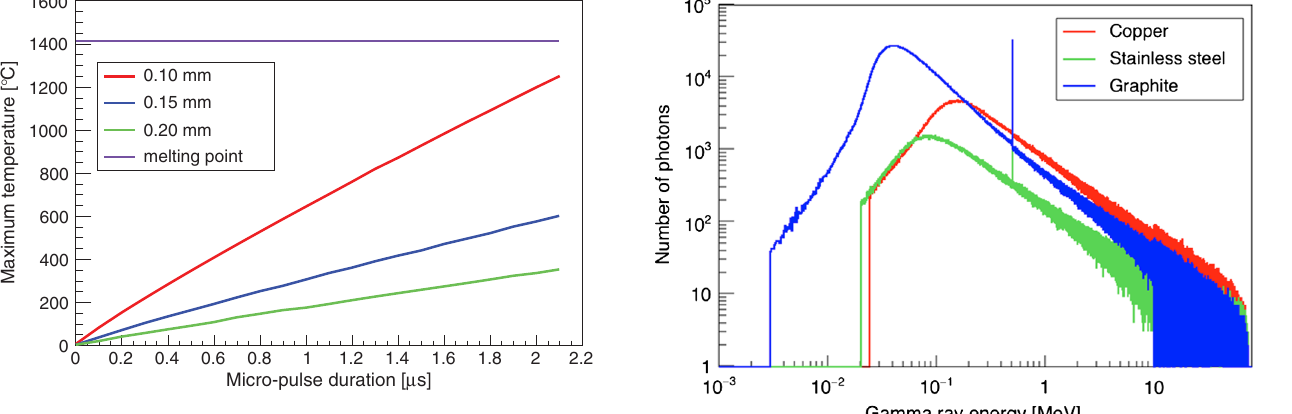
FIG. 12. Gamma rays generated when a beam with 10 7 electrons at 75 MeV collides with copper, stainless steal and graphite.